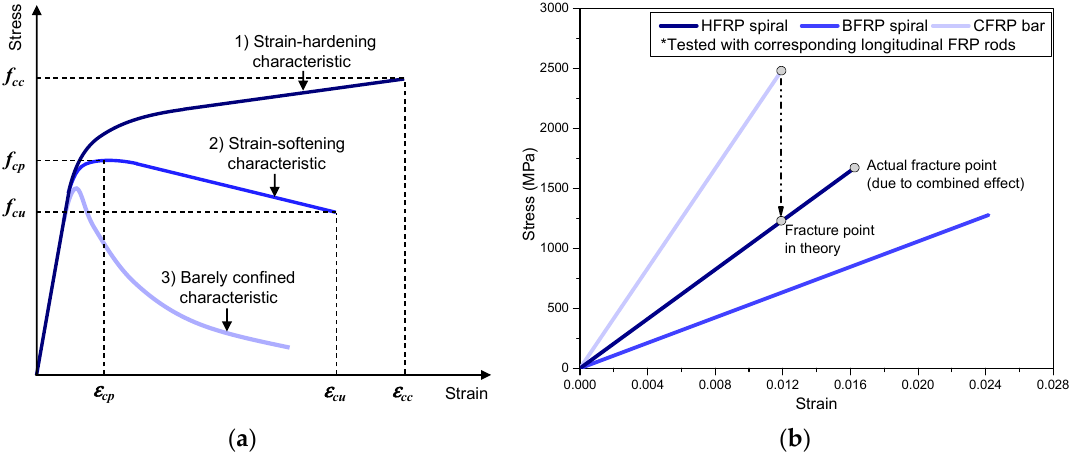
Figure 2. Confinement design principle and tensile properties of spirals: ( a ) confinement design principle; ( b ) tensile properties of different spirals.